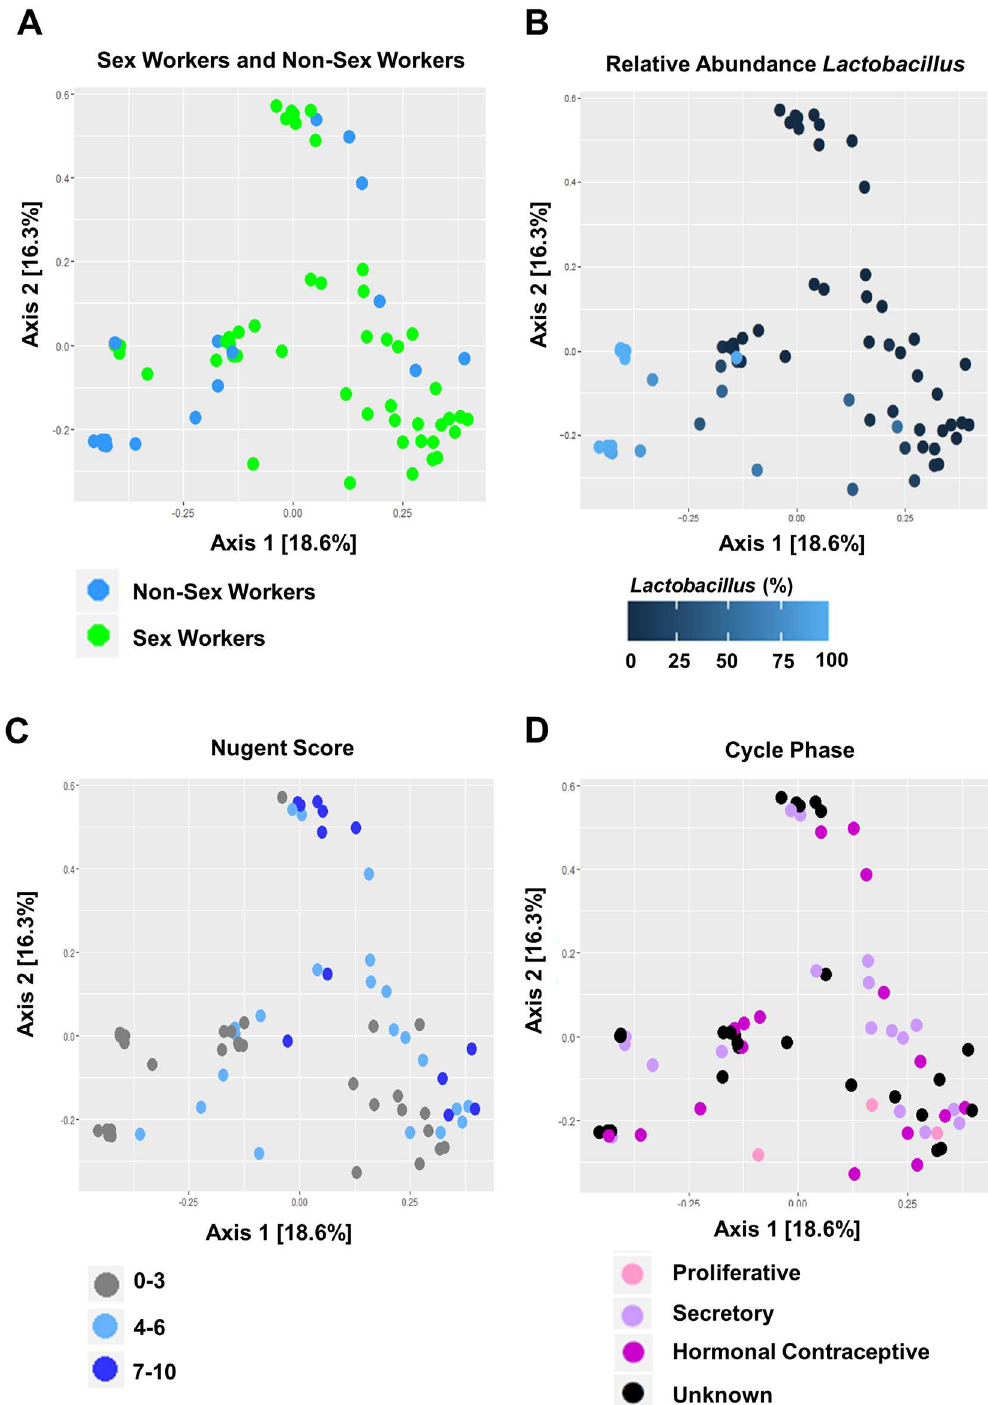
Fig 3. Principle coordinate analysis demonstrates clustering by relative abundance of Lactobacillus . PCoA plots demonstrate the beta-diversity of the vaginalmicrobiotaof Non-Sex Workers (NSW, N = 19), and Female Sex Workers (FSW, N = 48). The vaginalmicrobiotadid not appearto cluster by group (NSW vs. FSW; A). When colouredby the relative abundance of Lactobacillus one main cluster dominant in Lactobacillus were revealed(B). The strongerintensity of blue indicatesgreater relative abundance. Some clusteringby Nugent Score (C) was also observed(0–3: grey, 4–6: light blue, 7–10: dark blue). The vaginalmicrobiotadid not appearto strongly cluster by